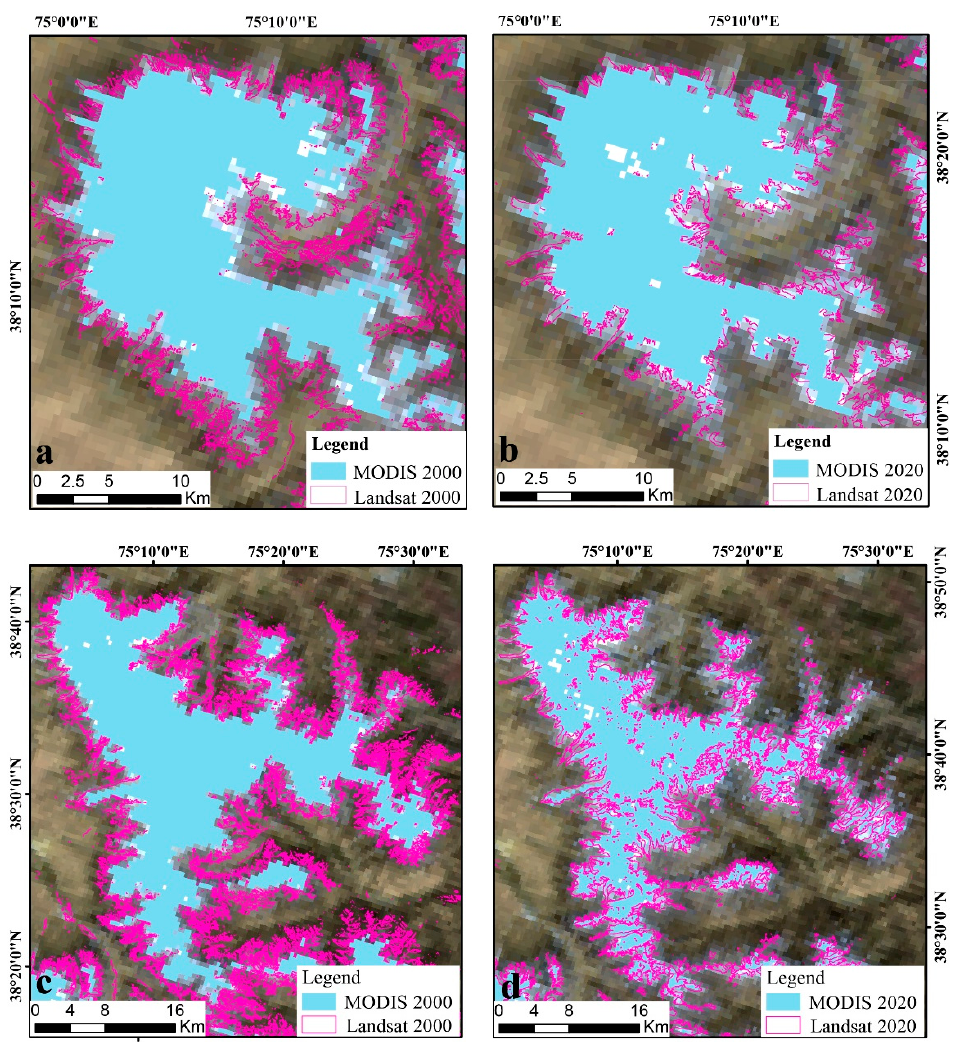
Figure 3. Delineation of glaciers: ( a ) Muztag 2000; ( b ) Muztag 2020; ( c ) Kungur Tagh 2000; ( d ) Kungur Tagh 2020. The background is the MODIS 2020 true color composite images (Red = Band 1, Green = Band 4, Blue = Band 3). The size of one image pixel is 500 m.